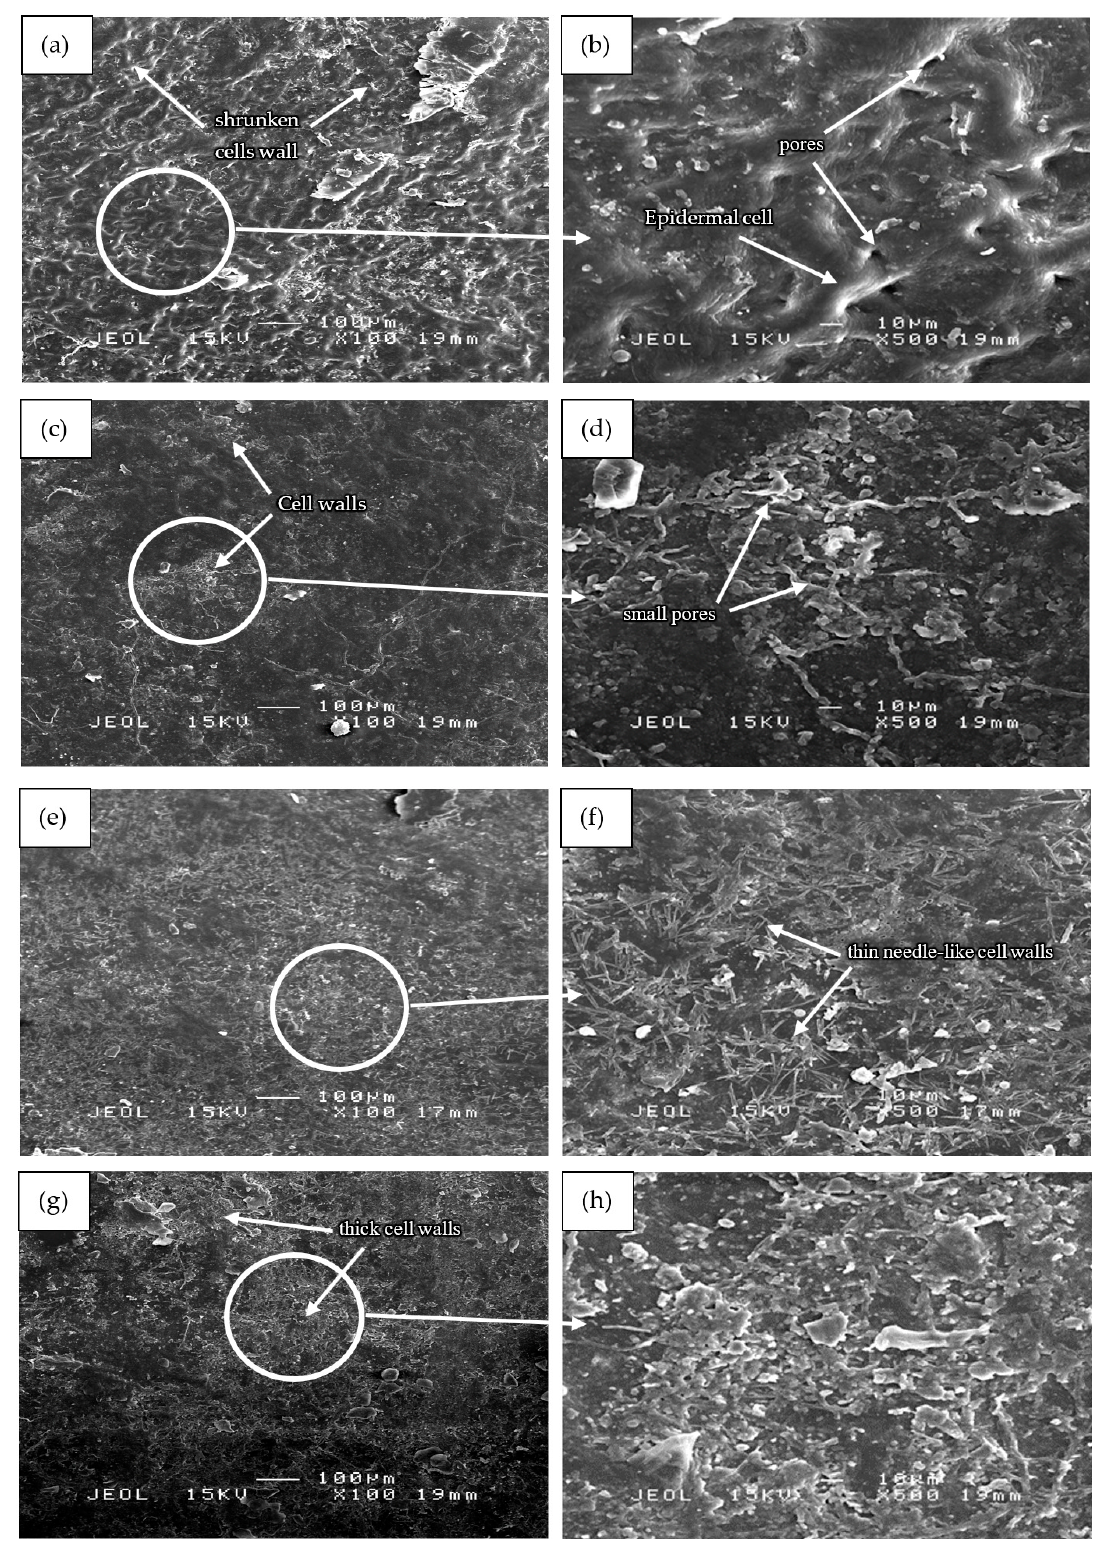
Figure 6. SEM micrographs of ( a , b ) boiled dry mangosteen leaves without glycerol, ( c , d ) sample S35, ( e , f ) sample S19, and ( g , h ) sample S26 at 100× and 500× magnification. and ( g , h ) sample S26 at 100 × and 500 ×